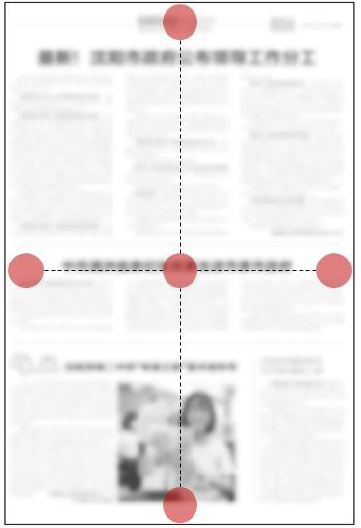
Figure 4. The selected points of the illumination value.